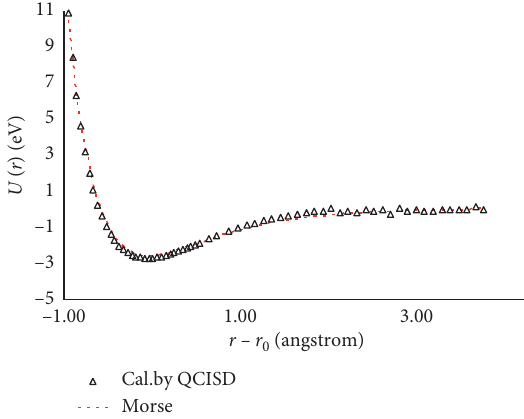
Figure 3: Potential energy vs. diatomic distance for UH.